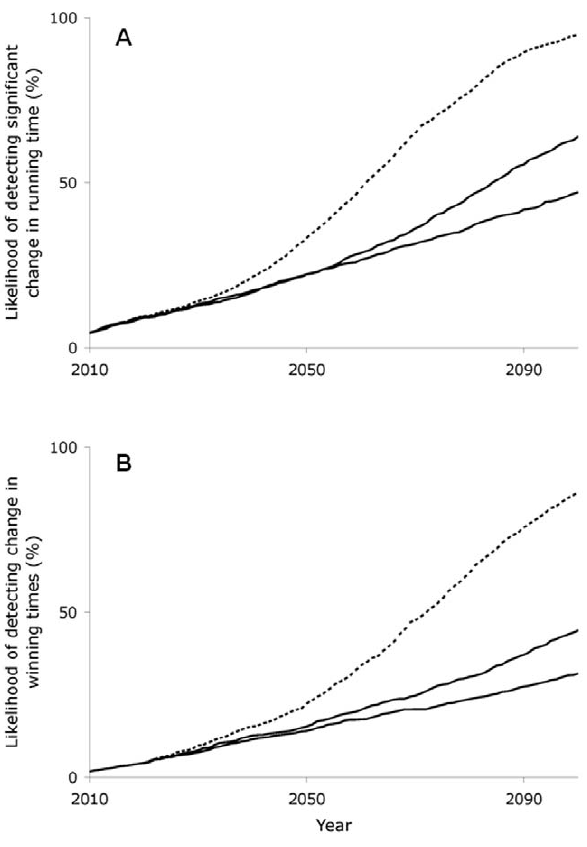
Figure 3. Effects of (A) temperature and (B) wind on winning times in the Boston Marathon from 1933 to 2004. Using coefficients determined by least squares regression (Table 1), we estimated winning times from the equations, (A) predicted winning time = a + b 1 world record + b 2 wind and (B) predicted winning time = a + b 1 world record + b 2 temperature. The residuals plotted here represent the difference between each year’s predicted winning time and actual winning time (residual = actual – predicted). Open diamonds represent men’s residuals. Solid circles represent women’s residuals. Lines represent least squares best fit for men (dashed) and women (solid).